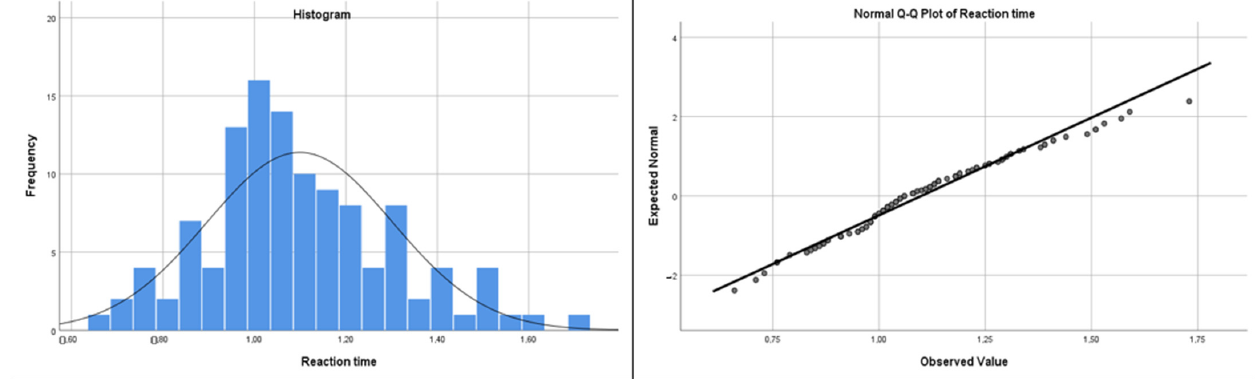
Figure 6. Graphical analysis of the normality. Source: own collaboration.